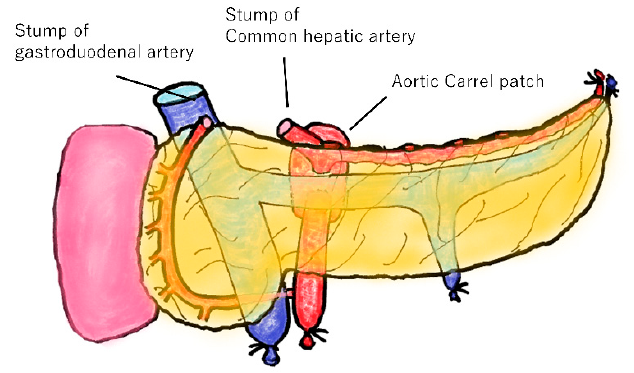
Figure 2. Typical pancreatic graft in Japan.